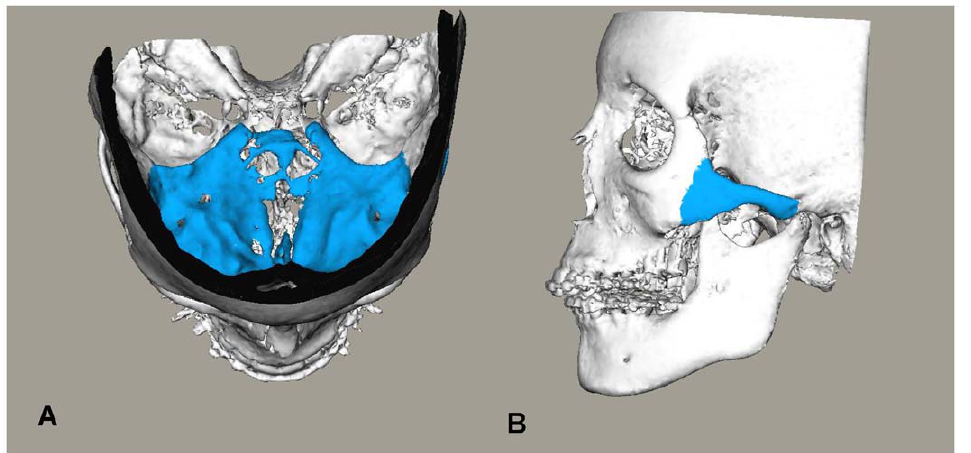
Figure 1. Anatomic structures used for registration highlighted on 3D CBCT models. Anatomic structures used for the registration highlighted on the 3D CBCT models. (A) Anterior cranial base. (B) left zygomatic arch.